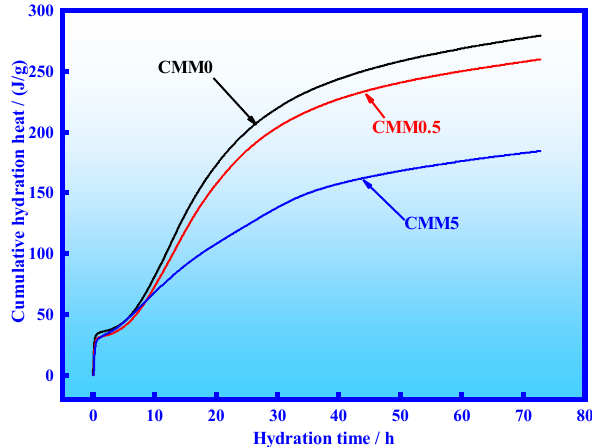
Figure 8. CMM cumulative hydration heat within 72 h.